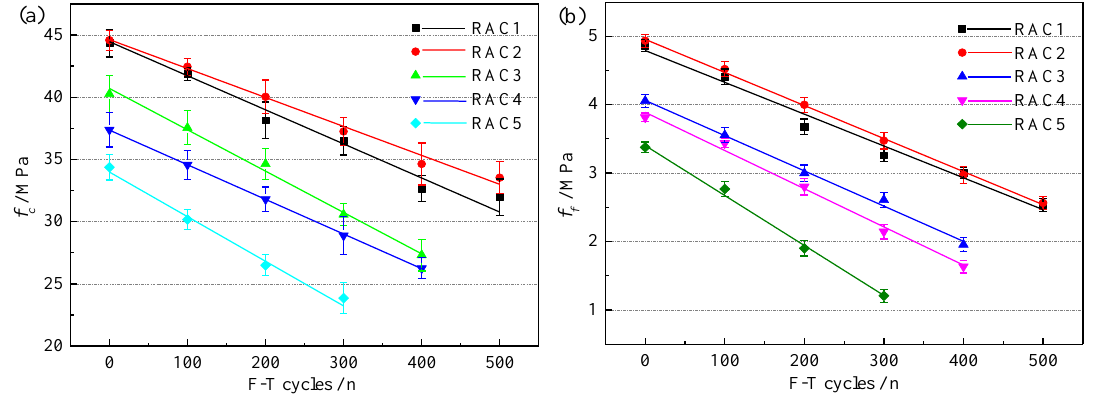
Figure 9. The variations of f c ( a ) and f f ( b ) of RAC- i.